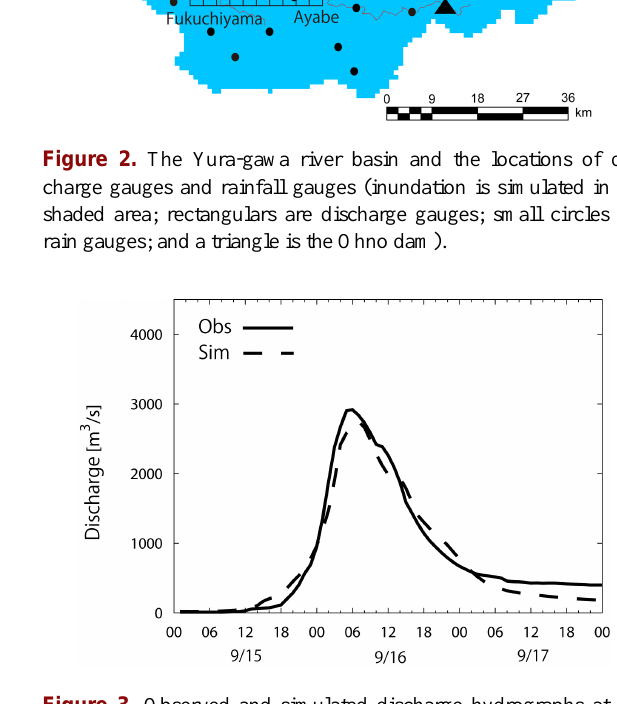
Figure 3. Observed and simulated discharge hydrographs at the Ayabe stations for the typhoon No. 18, 2013 (the solid line is the observed hydrograph; the broken line is the simulated